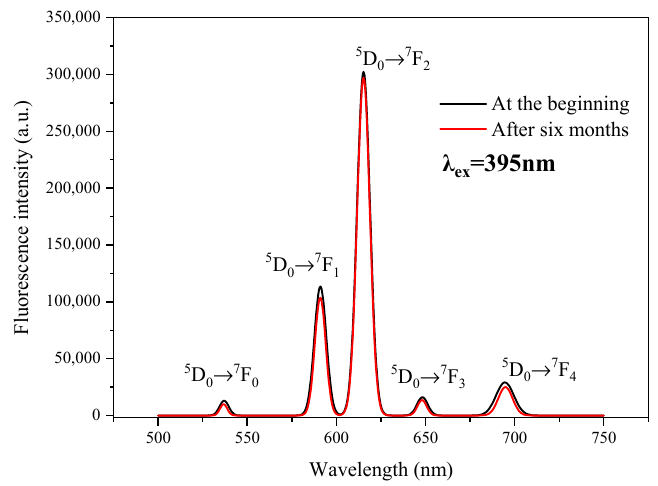
Figure 3. Fluorescence emission spectra of CMC/Eu ( Ⅲ ) in suspension.